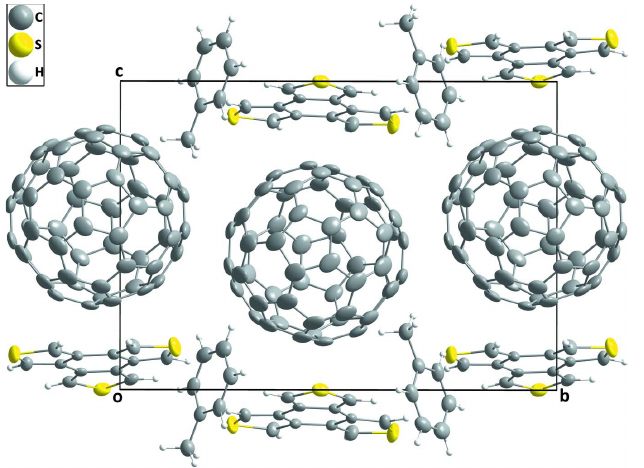
Figure 4 Packing of BTT- D 3h (cid:2) C 60 (cid:2) toluene viewed along the a -axis direction. Minor disordered atoms are omitted for clarity.